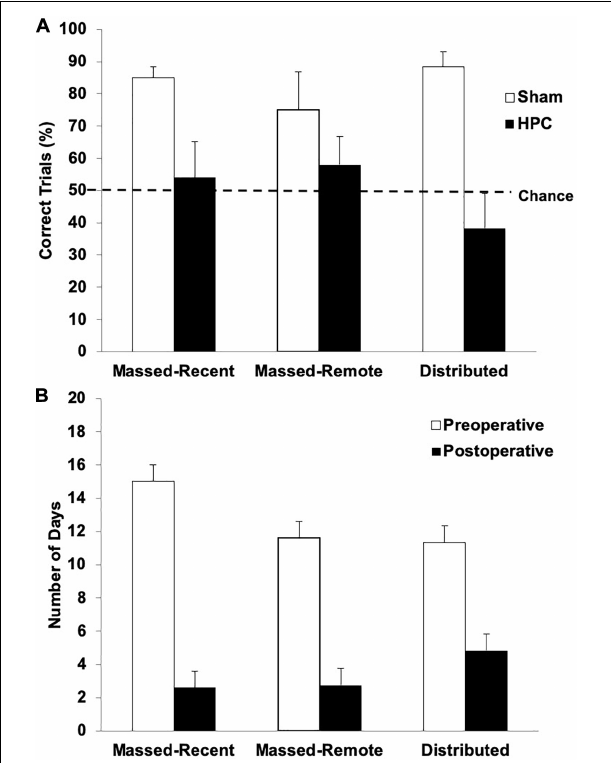
FIGURE 3 | (A) Mean (+SEM) percent of correct trials during the post-surgical visual discrimination retention test for Sham and HPC rats in the massed/recent, massed/remote, and distributed conditions. Each Sham group showed a statistically significant bias (above 50%) in swimming to the S+ ( ps < 0.05), suggesting that the control rats remembered the discrimination. In contrast, none of the HPC groups showed a preference for selecting the S+ ( ps < 0.05) and showed fewer correct trials than the control rats ( p < 0.05). Thus, the HPC rats, regardless of training condition, suffered from retrograde amnesia and the additional 50 training trials beyond criterion learning did not enable the memory to become more resistant to HPC damage. (B) Mean (+SEM) number of days for HPC rats in the massed/recent, massed/remote, and distributed conditions to relearn the visual discrimination compared to their pre-surgical performance (pre-surgical data also shown in Figure 2A ). The lesion rats in all three conditions relearned the task in significantly fewer days than it took to learn the task initially ( p < 0.05), suggesting that there was some memory trace remaining in non-HPC